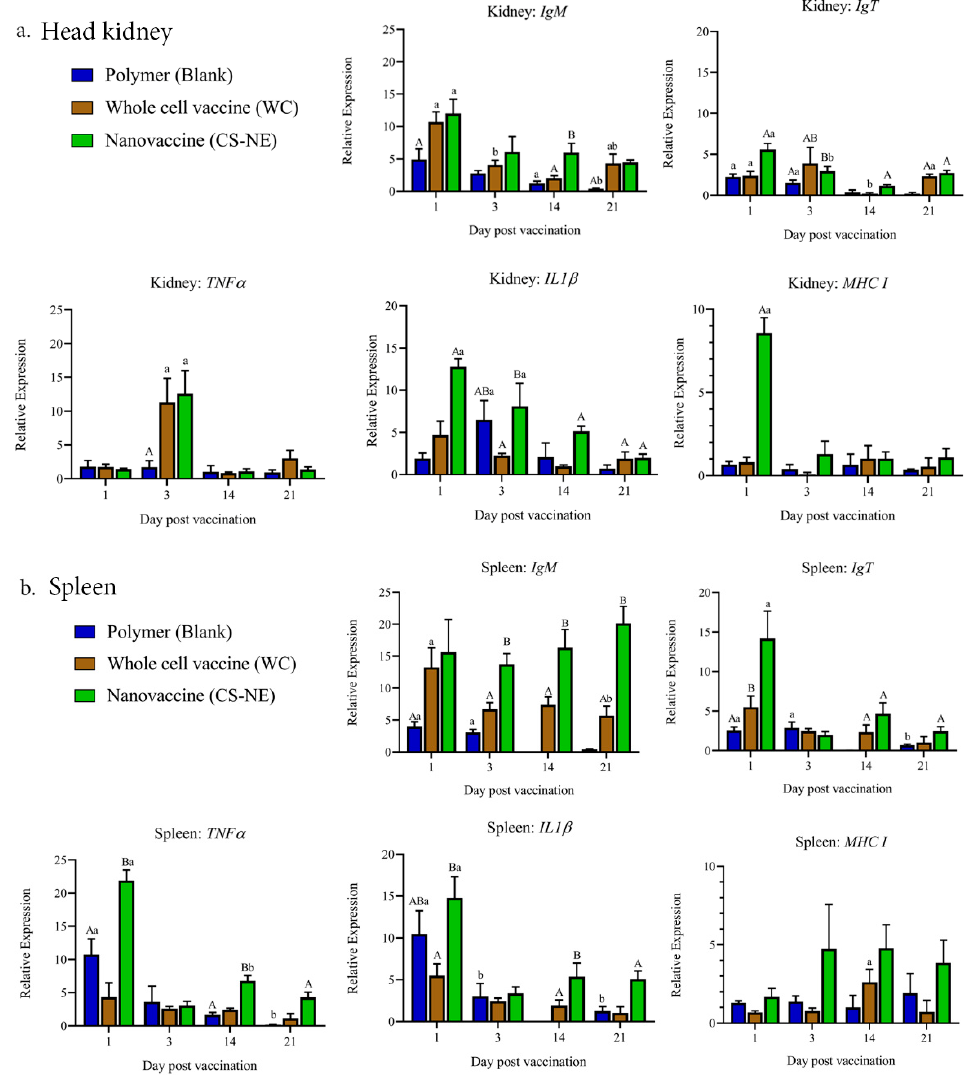
Figure 7. Gene expression of five immune genes— IgM , IgT , IL1 β , TNF- α , and MHCI in the head kidney ( a ) and spleen ( b ) of vaccinated fish (CS-NE (green), WC (brown), Polymer (blue)) relative to unvaccinated control fish at 1, 3, 14, and 21 days post-vaccination. Different capital letters indicate significant differences at p < 0 . 05 among groups at each time point. Different small letters indicate significant differences over time within each group (N = 6). Two-way analysis of variance, and repeated measures analysis of variance followed by Bonferroni’s multiple comparison test were used for statistical analysis .